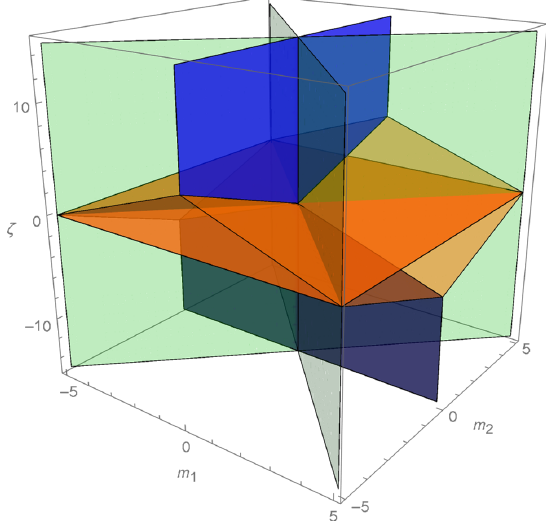
Figure 1 . Phase diagram of the SQED 2 model. The blue, orange, and green planes denote Higgs, Coulomb, and mixed branches, respectively. The remaining parameter space admits only two massive vacuum